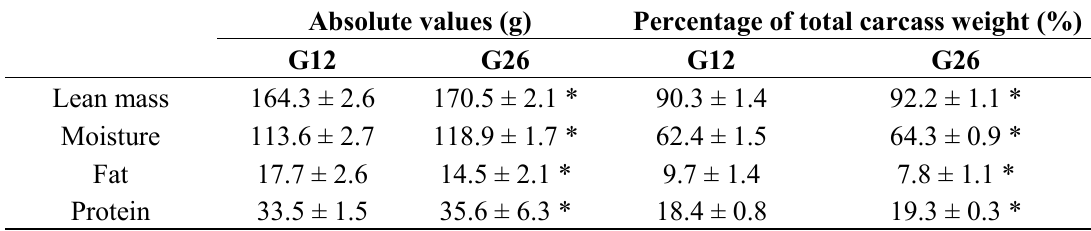
Table 6. Carcass composition of the experimental groups 1,2